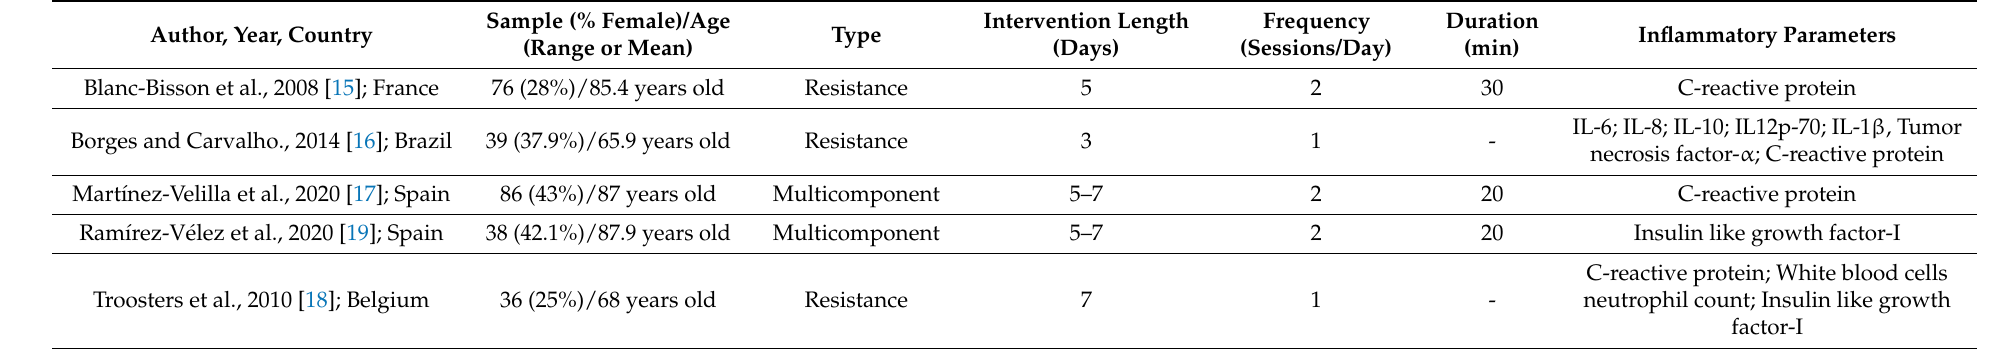
Table 2. Summary of included